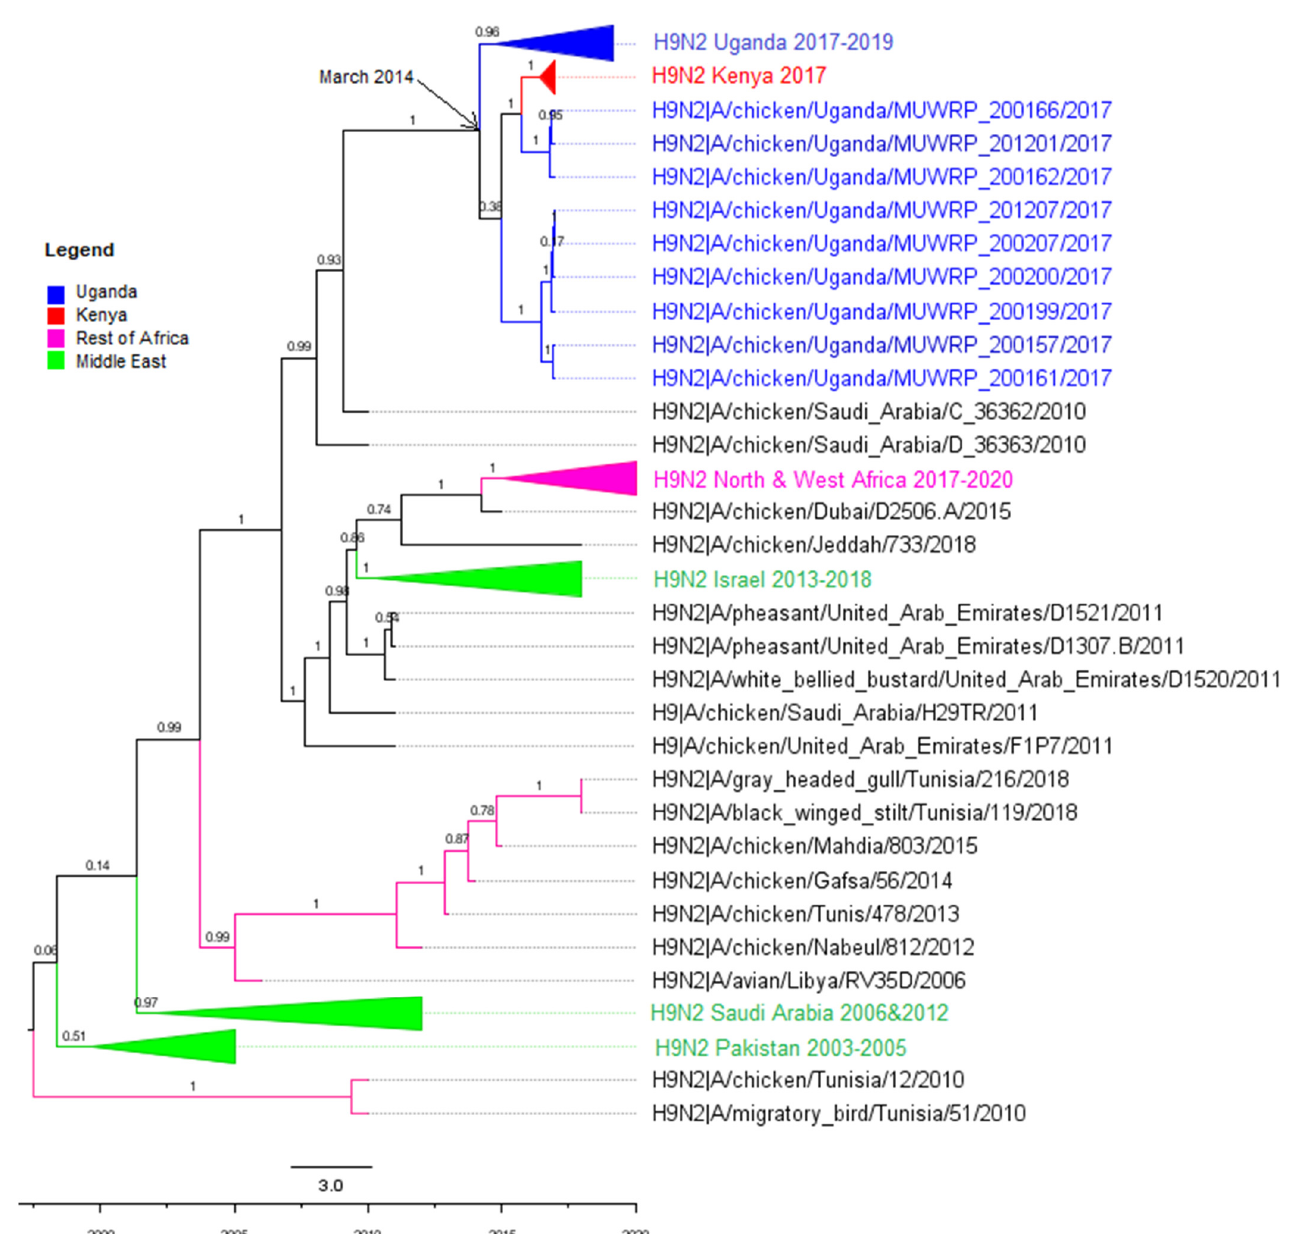
Figure 1. Phylogenetic tree for HA . Ugandan viruses are highlighted in blue, Kenyan in red, North and West African countries in pink, and the Middle East in the green clade. Posterior probabilities are shown on the branches. The top scale represents the estimated number of substitutions and the bottom scale shows time of divergence. HKY + G (4) nucleotide substitution model and an MCMC of 100 million states was applied in BEAST to generate this tree .